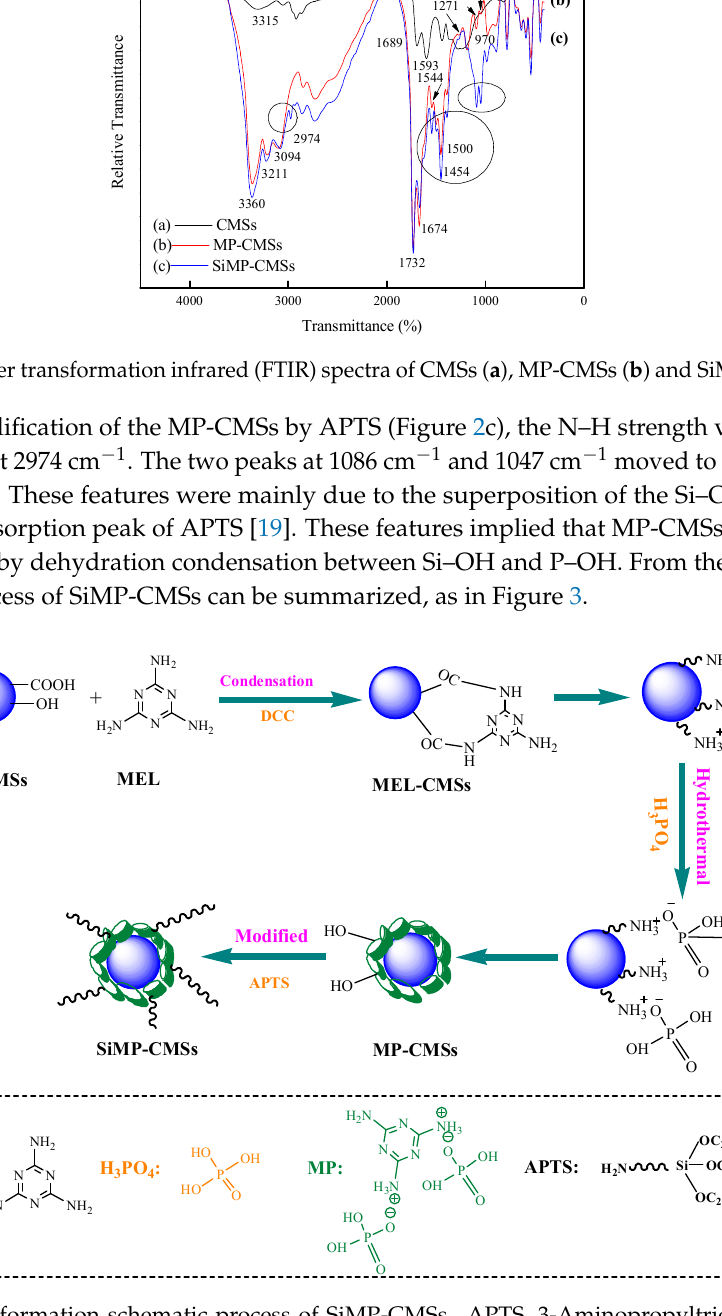
Figure 3. The formation schematic process of SiMP-CMSs. APTS, 3-Aminopropyltriethoxysilane; MEL, melamine.